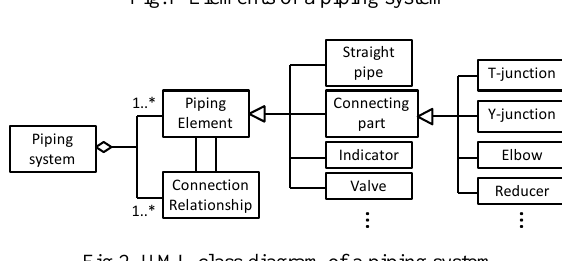
Fig.1 Elements of a piping system